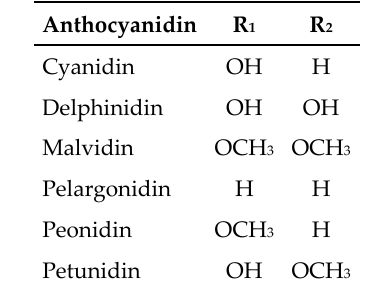
Figure 1. Anthocyanidin structures.